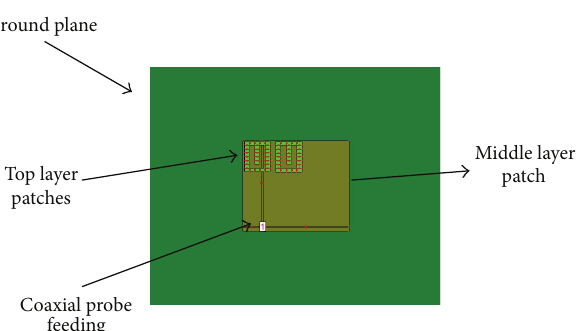
Figure 2: Optimization model for